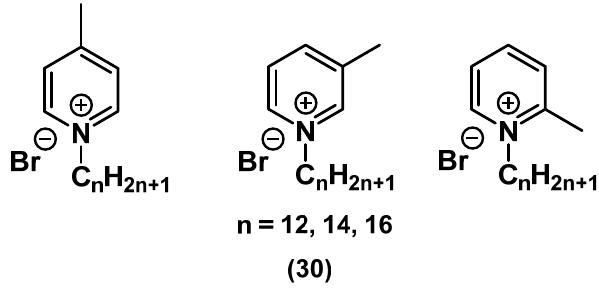
Figure 15. Picolinic mono-QACs.